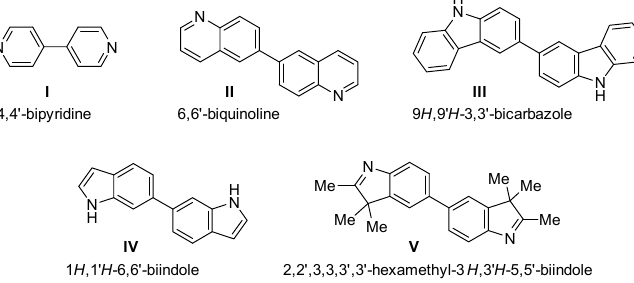
Figure 1. Examples of synthetically relevant biheterocycles.